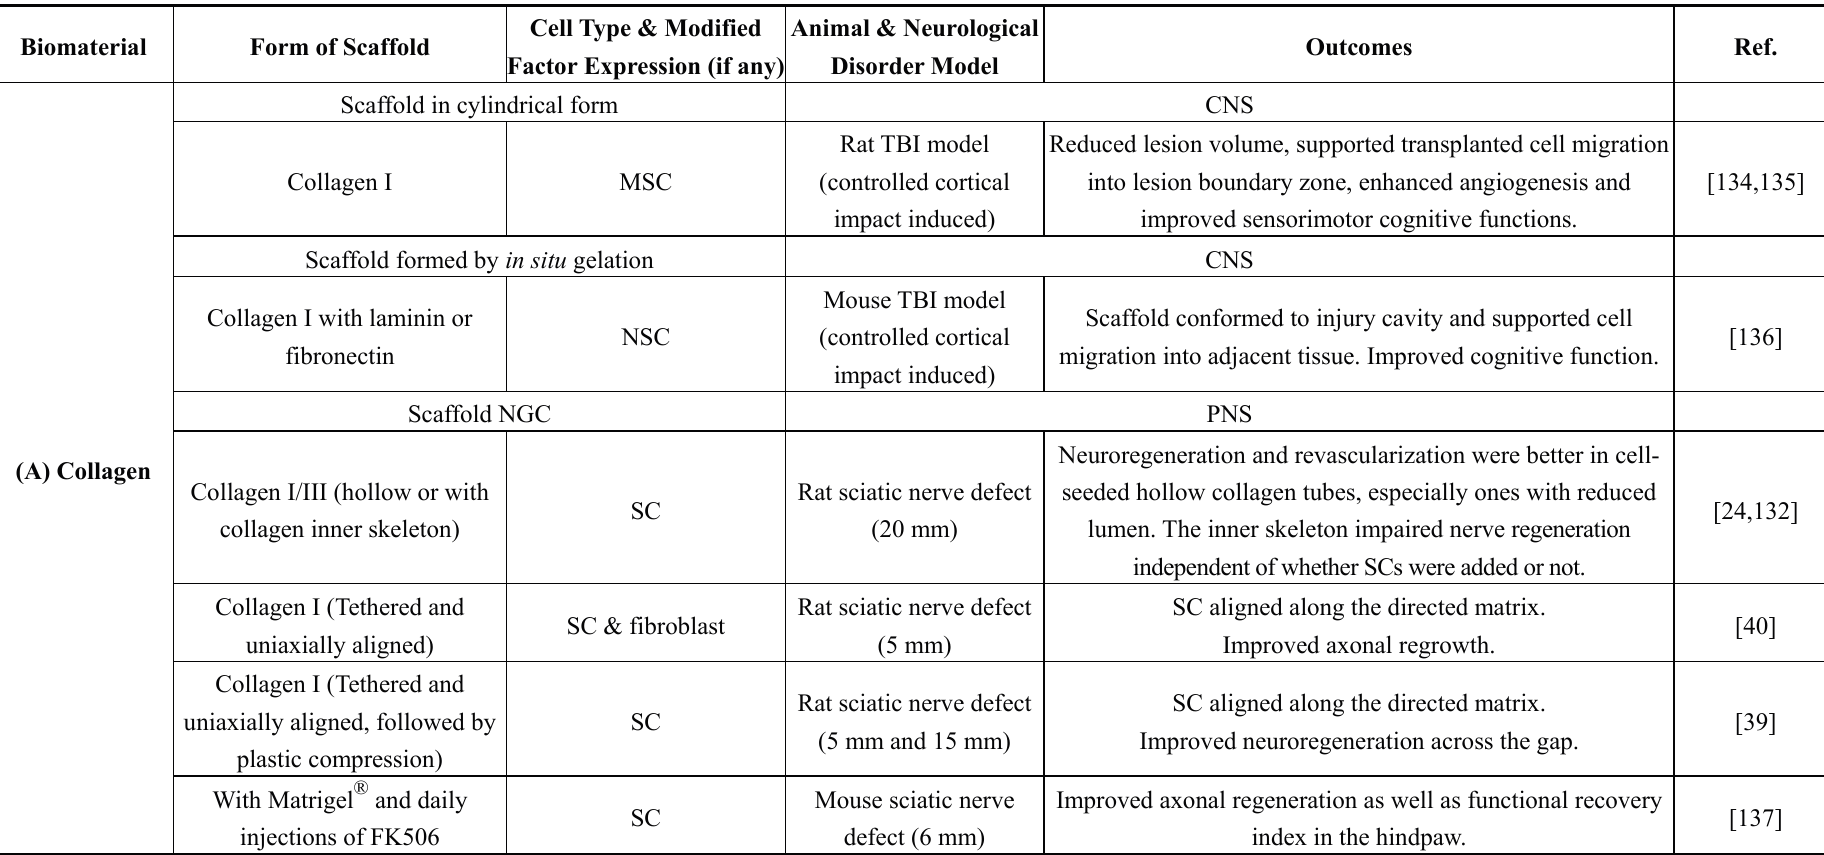
Table 3. Examples of biodegradable cell-carriers composed of Extracellular matrix components and their derivatives in preclinical animal studies and clinical